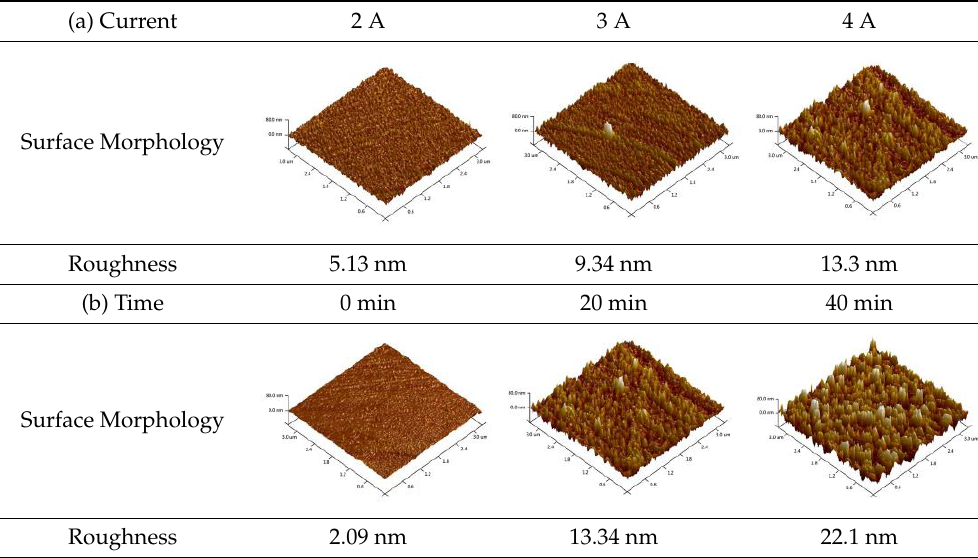
Table 1. Effect of (a) ion source currents, (b) bombardment time on surface roughness.